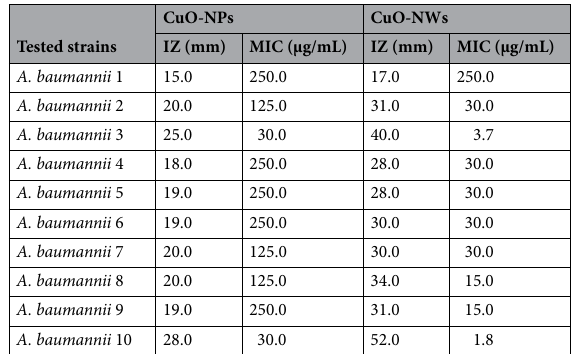
Table 2. Antibacterial effect of CuO-NWs & CuO-NPs against Acinetobacter baumannii strains.